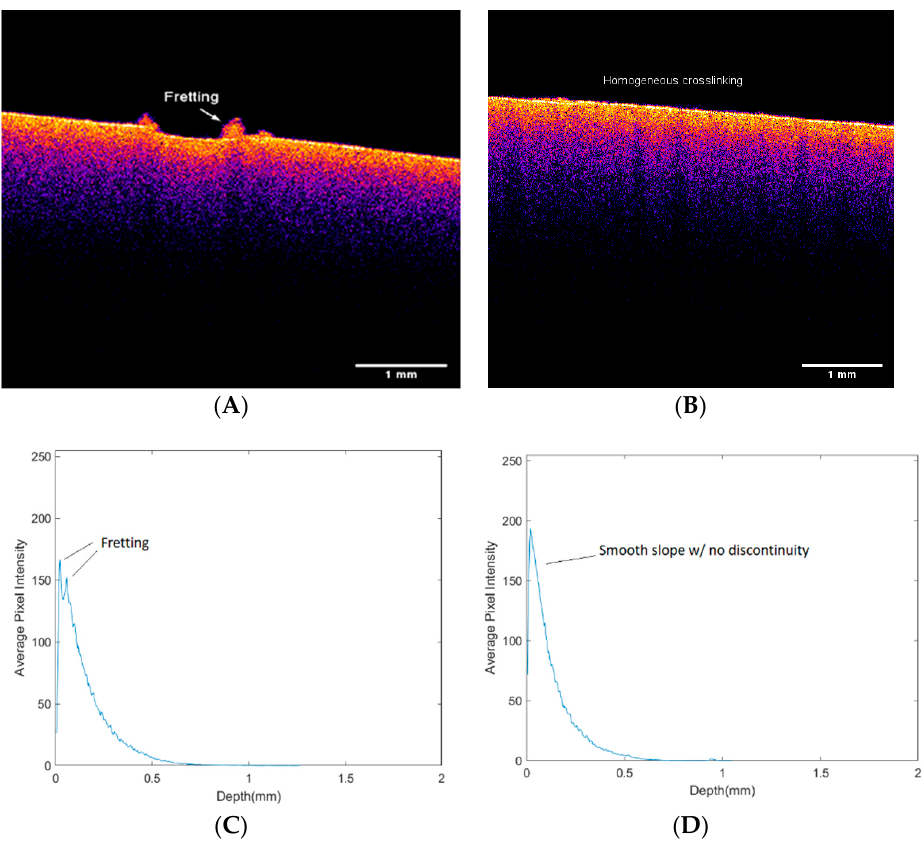
Figure 4. Color-coded OCT images of silicone rubber specimens and pixel intensity versus depth plots. Note the specimen with surface fretting ( A ), which is not discernible with visual inspection of the specimen and the unfretted surface ( B ). There is a noticeable dip in the pixel intensity at exactly the depth that denotes the surface of the material, which directly correlates to the fretting ( C ) on the material surface. A specimen with homogeneous crosslinking on the surface and in the visible depth of the OCT image ( D ) is shown to have a smooth slope with no jumps in pixel intensity.